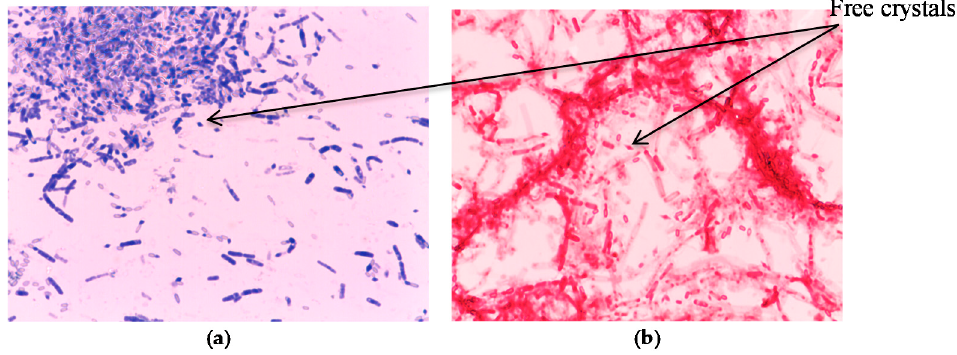
Figure 2. Nikon ECLIPSE 50i microscope indicating crystals using Brilliant Blue R 250 staining ( a ) and BAM method ( b ); Oil immersion magnification 100×.